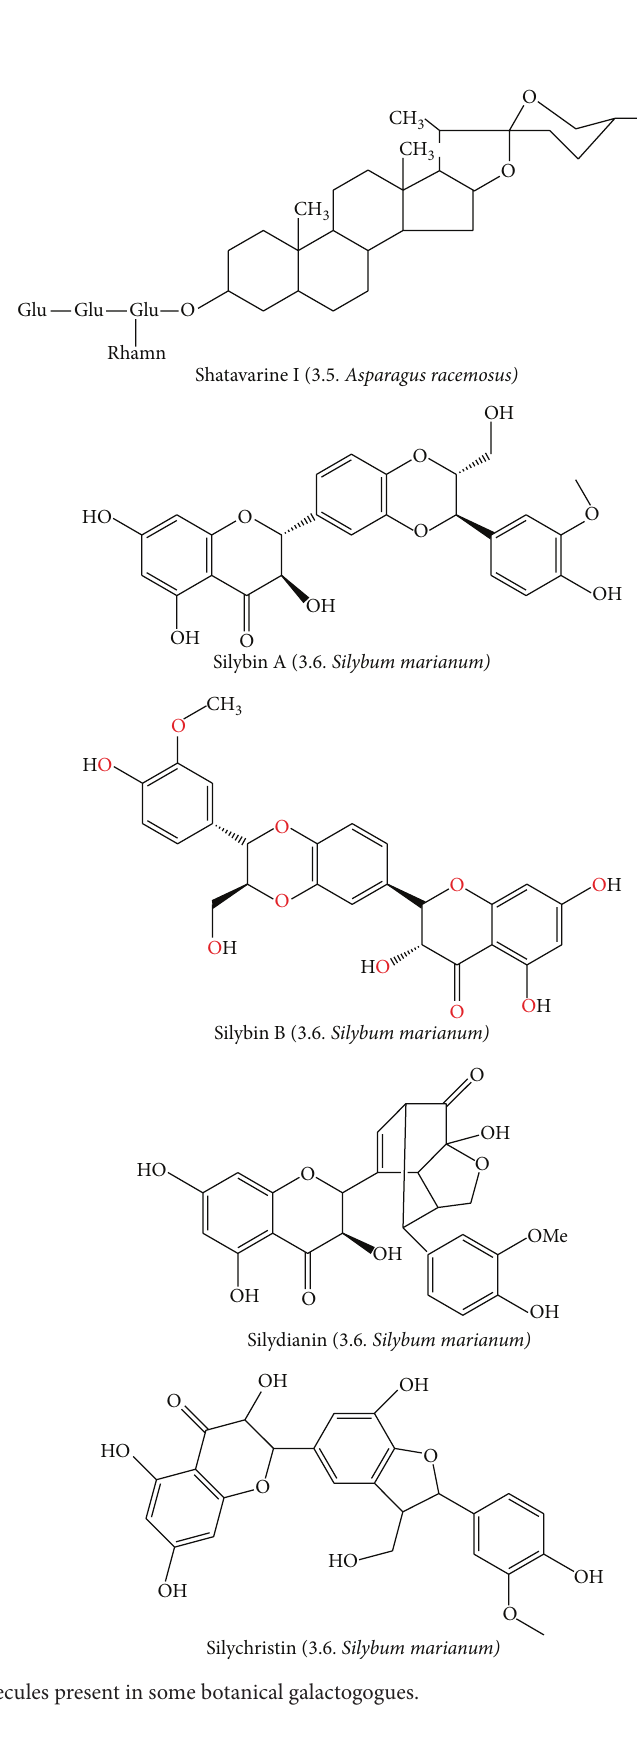
Figure 6: Phytoestrogenic molecules present in some botanical